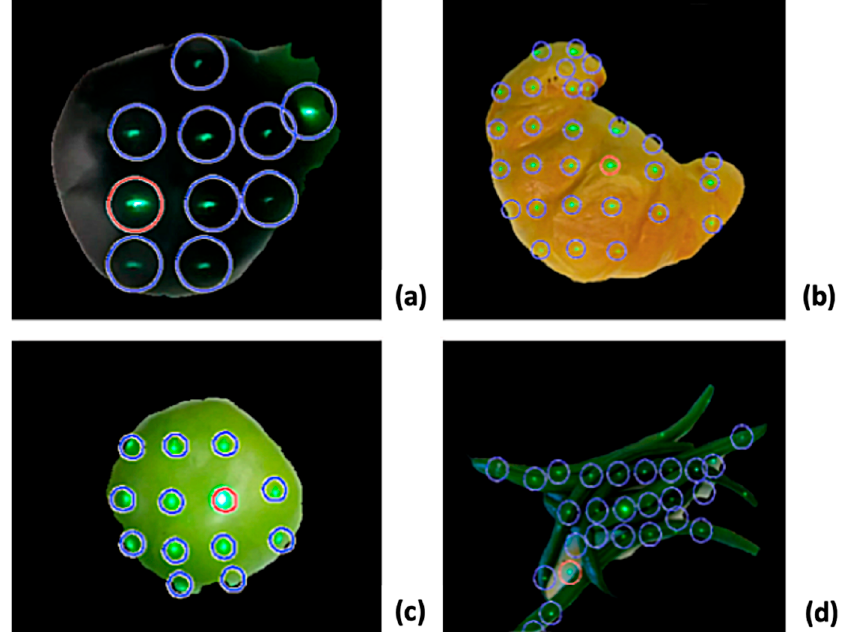
Figure 15. Preliminary results of the automatic dot selection algorithm and edge detection show the ability to crop and detecting dots on round, sharp, and irregular shapes of food, such as: ( a ) a pear, ( b ) a croissant, ( c ) an apple, and ( d ) green beans.